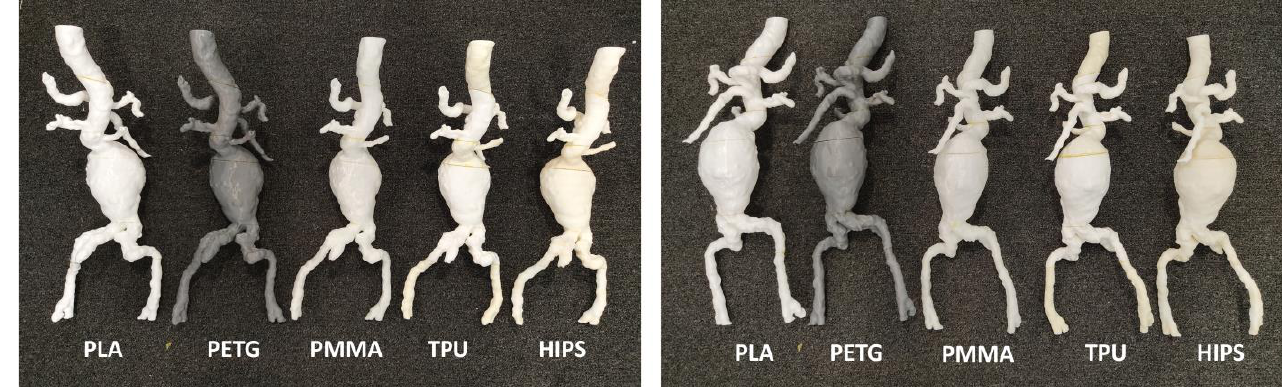
Figure 12. 3D-printed abdominal aortic aneurysm models with use of different materials (left image: posterior view, right image: anterior view). These models were used as a pilot test to identify the appropriate material to develop vascular models for the simulation of EVAR procedures. EVAR— endovascular aneurysm repair. HIPS—high impact polystyrene, PLA—polylactic acid, PETG— polyethylene terephthalate glycol, PMMA—polymethacrylate, TPU—thermoplastic polyurethane.